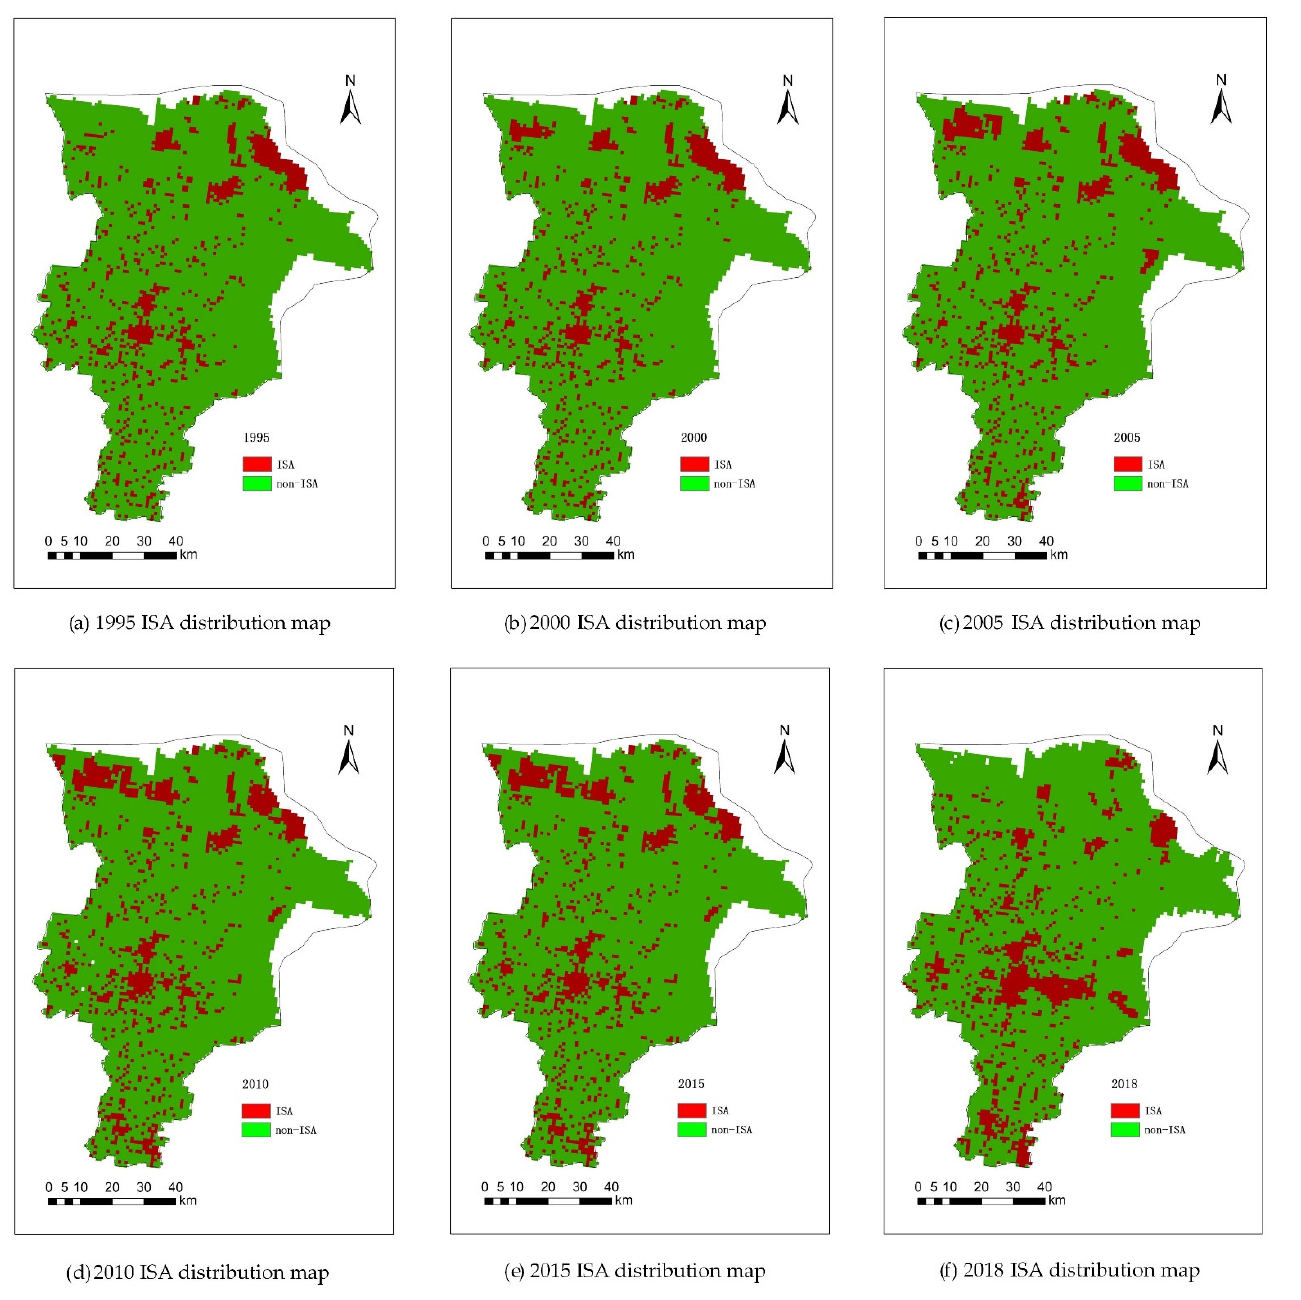
Figure 10. Remote sensing monitoring data of land use status in Dongying City from 1995 to 2018.